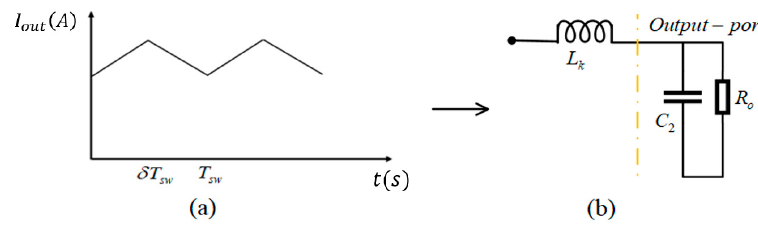
Figure 6. ( a ) Positive non-pulsed output-port current and ( b ) circuit diagram.